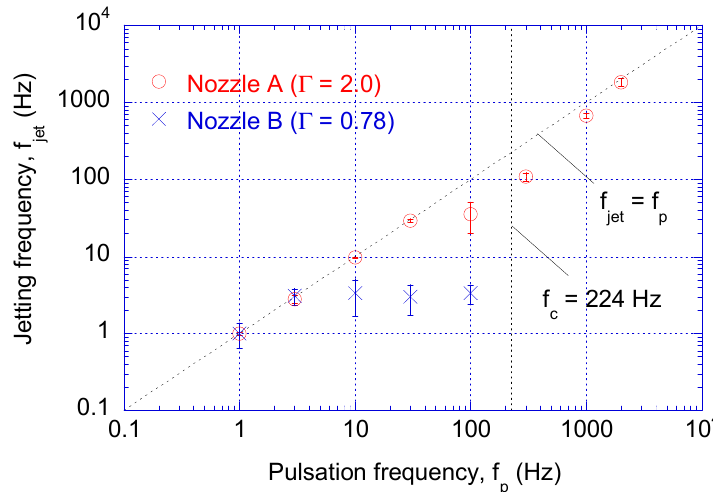
Figure 5. Measured jetting frequency as a function of pulsation frequency. Jetting frequency is in good agreement with pulsating frequency for overdamped system (Nozzle A; Γ = 2.0), while jetting frequency does not increase with pulsation frequency at a few Hz for underdamped system (Nozzle B; Γ = 0.8).